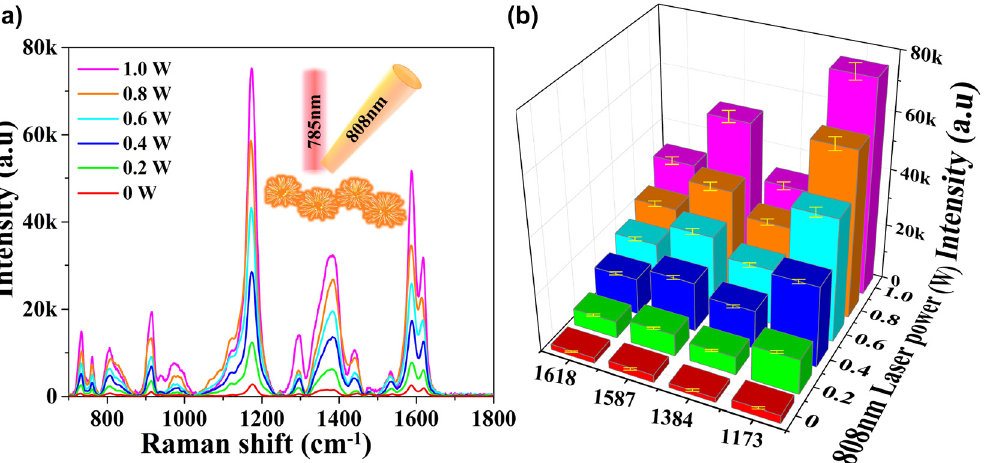
Figure 4: The SERS performances of Au/Ag NUs in the double laser-induced system. (a) Raman signals of CV (10 − 5 M) in Au/Ag NUs solution with different extra laser powers. (b) The variation trends of the main four Raman peak intensities of CV molecules (10 − 5 M) versus the extra 808 nm laser powers (0 – 1.0 W) (each error bar indicates the standard deviation of 10 different